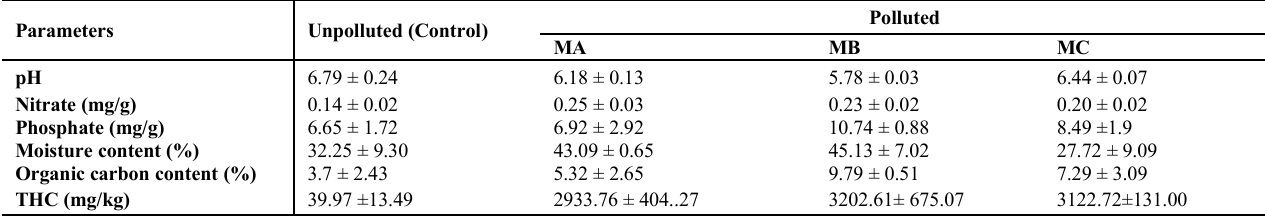
Table 4: Phenotypic characteristics of bacterial isolates from soil contaminated with waste engine oil.